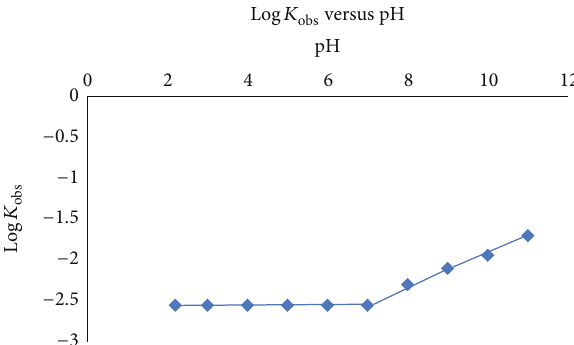
Figure 5: pH profile of colistin degradation at room temperature.